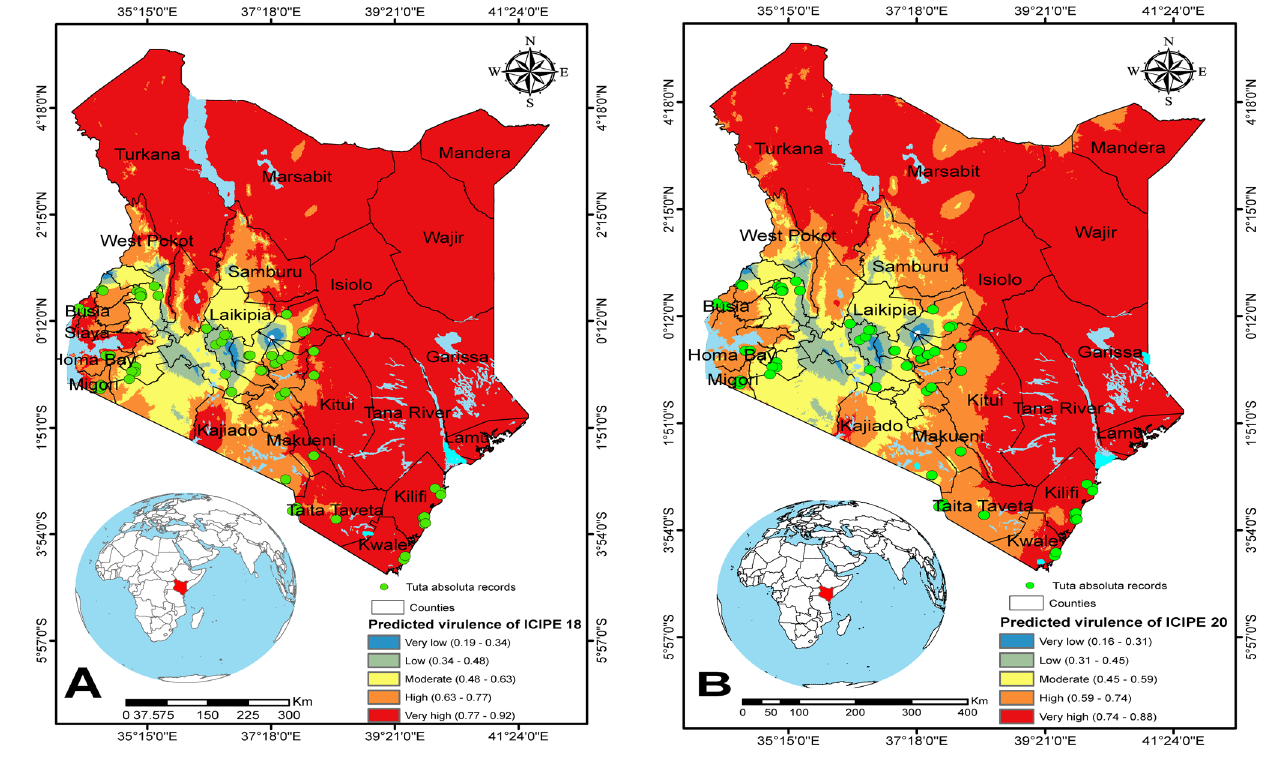
Figure 7. Spatial patterns of predicted virulence of Metarhizium anisopliae isolates ICIPE 18 and ICIPE 20 against adult Tuta absoluta in Kenya: ( A ) ICIPE 18 and ( B ) ICIPE 20. The dots in green indicate Tuta